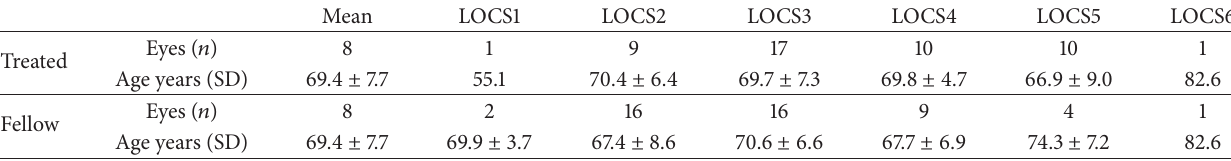
Table 3: Number of eyes and the mean subject age stratified per LOCS III grade.